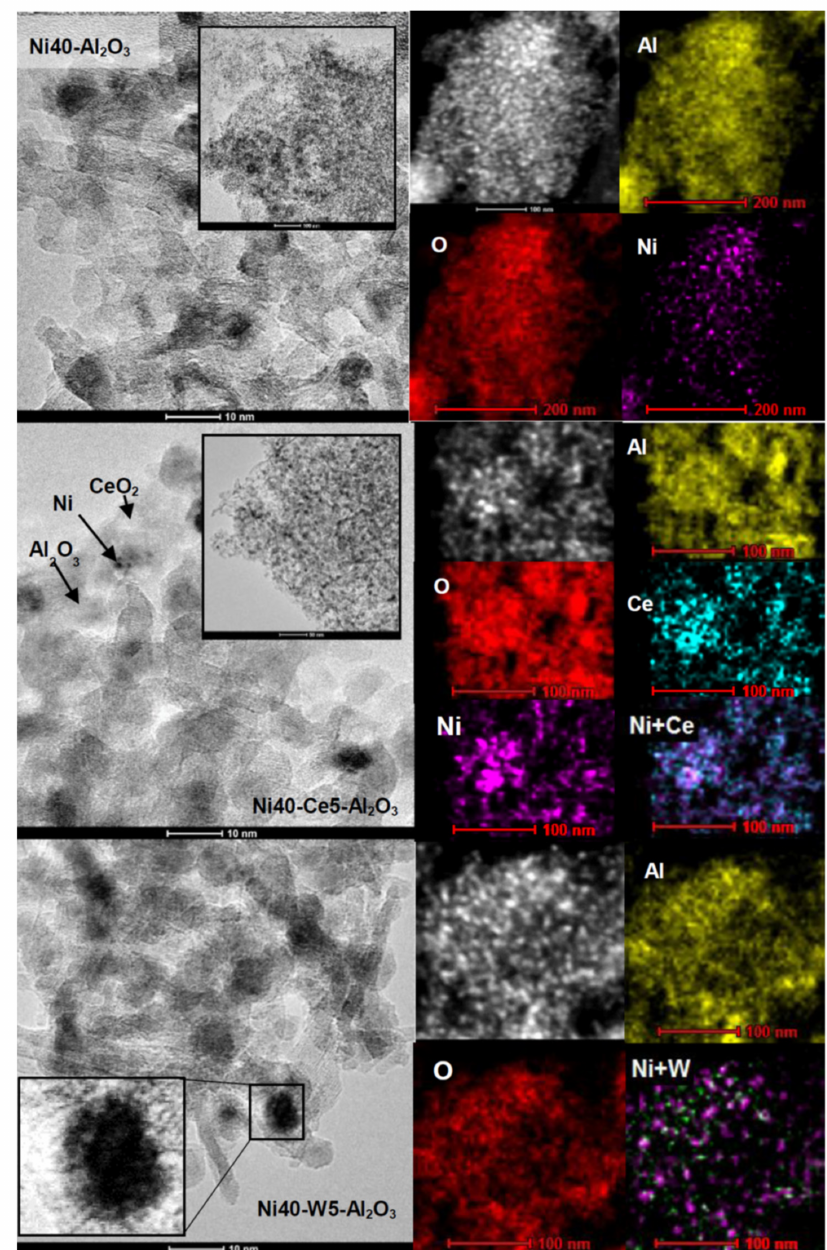
Figure 5. TEM ( left ) and STEM ( right ) images of Ni40-Al 2 O 3 , Ni40-Ce5-Al 2 O 3 , and Ni40-W5-Al 2 O 3 catalysts after